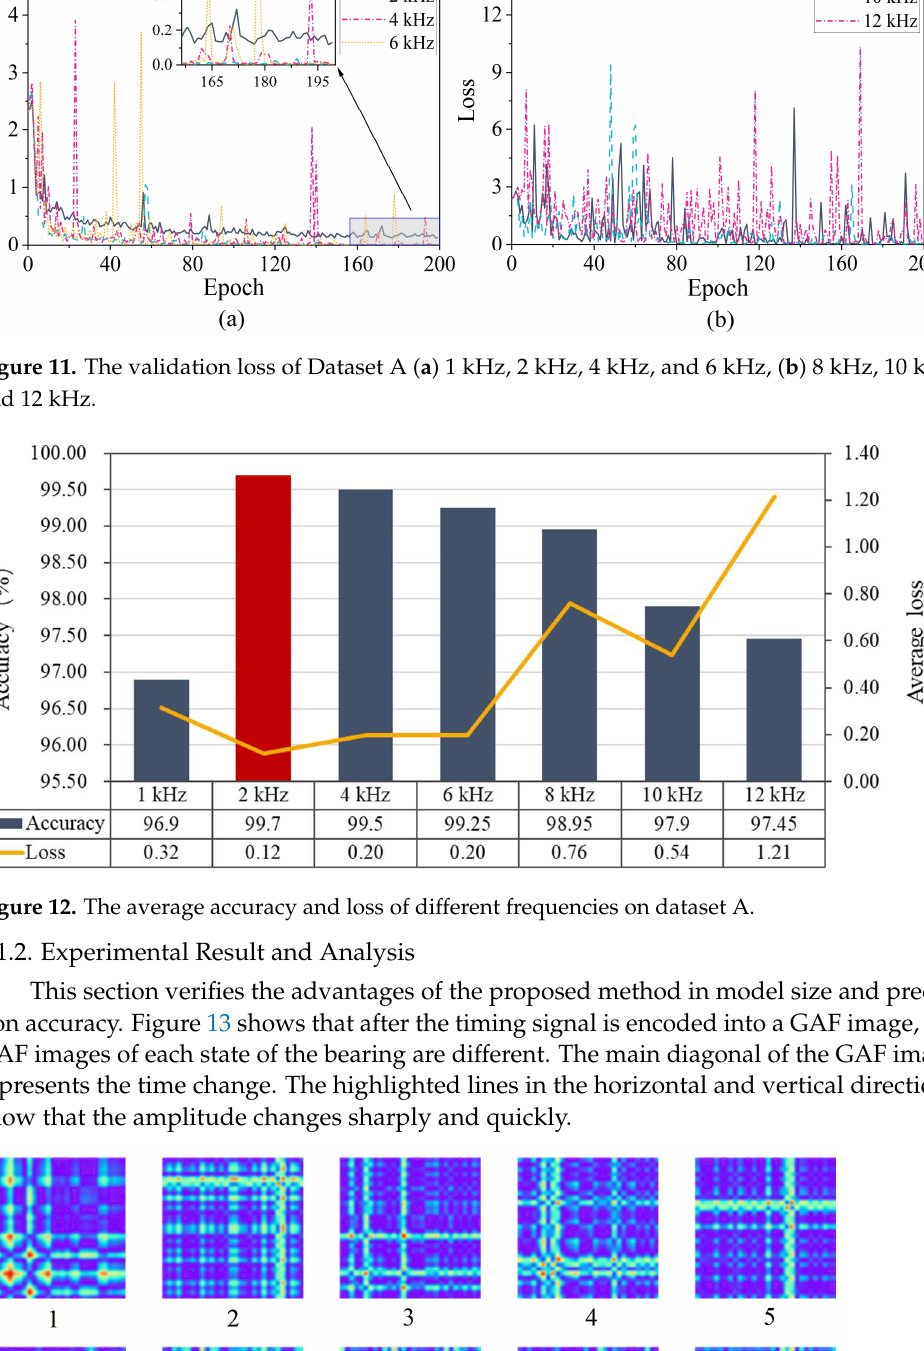
Figure 10. The validation accuracy of Dataset A ( a ) 1 kHz, 2 kHz, 4 kHz, and 6 kHz, ( b ) 8 kHz, 10 kHz, and 12 kHz.